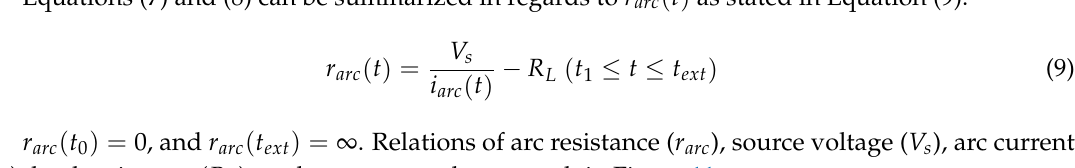
Figure 10. DC circuit within arc duration.